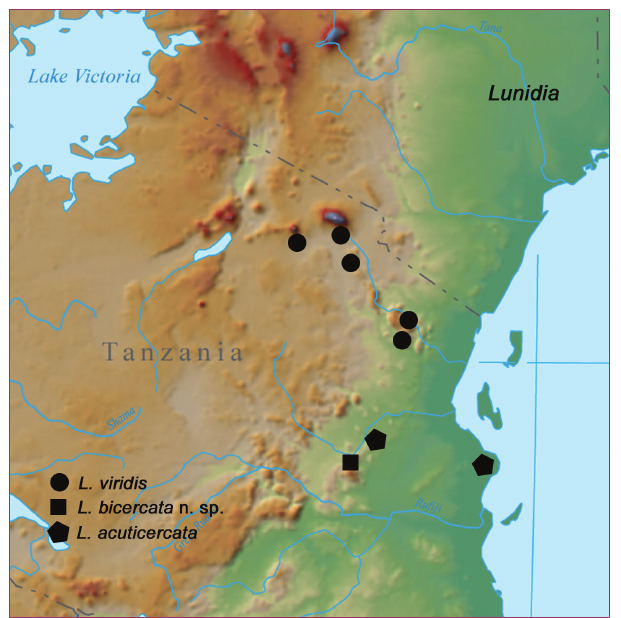
Fig. 5. Distribution of Lunidia species in East